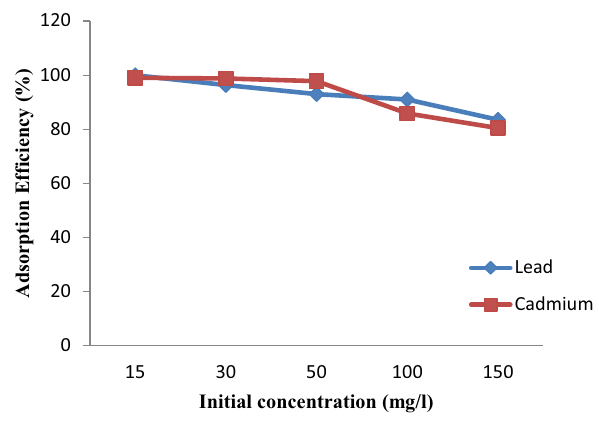
Fig. 2 Effect of concentration on Pb 2+ and Cd 2+ Adsorption by Opi soil